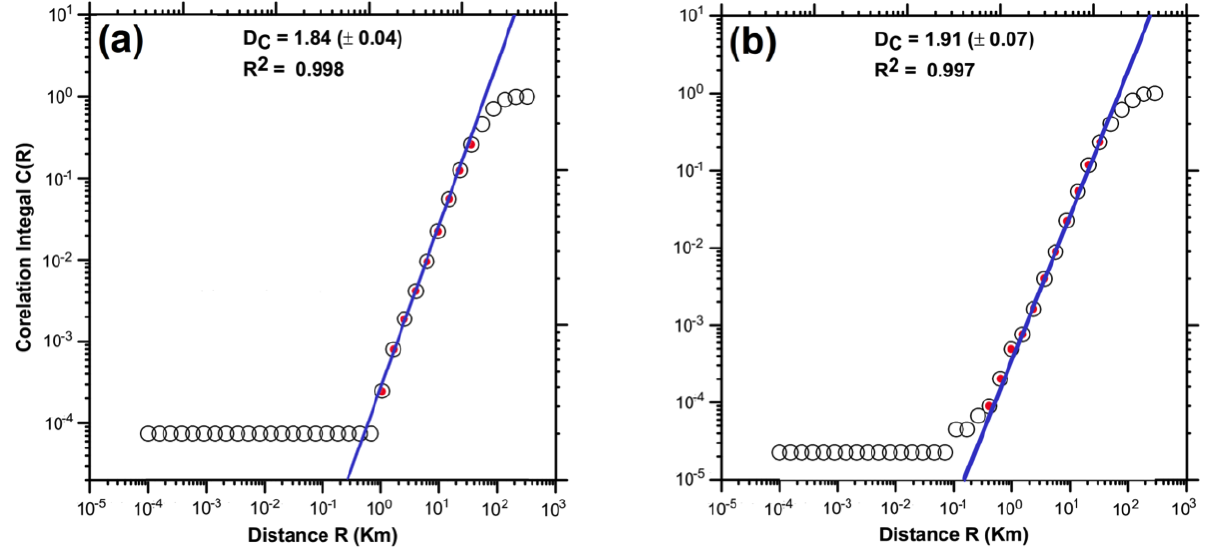
of both the aftershock sequences of (a) first ( M C